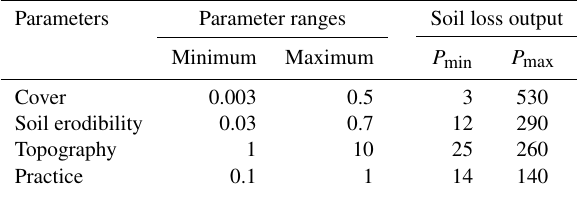
Table 4. Sensitivity of soil loss simulations (in t × 10 3 ) to model input parameter values. The P min and P max correspond to the min- imum and maximum values of the parameter,